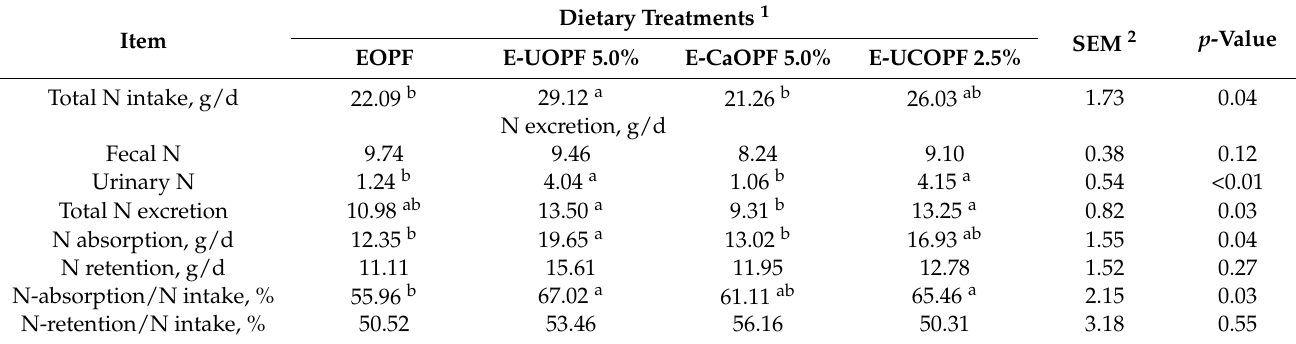
Dietary Treatments 1